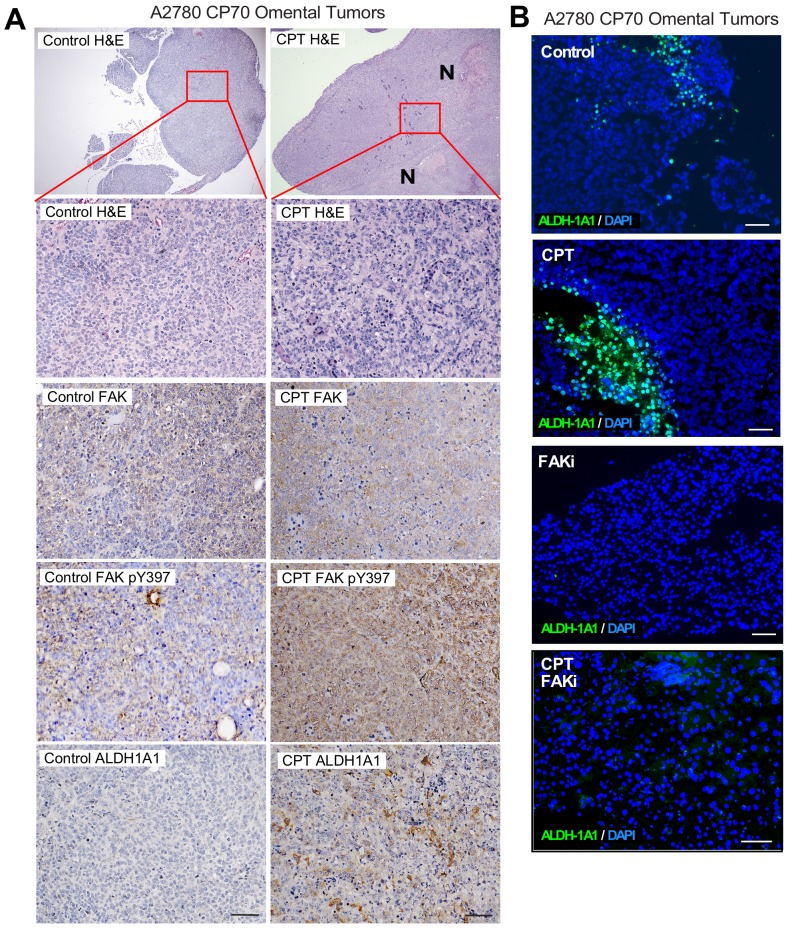
Elevated FAK Y397 phosphorylation and ALDH staining in non-necrotic regions of CPT-treated mice with A2780-CP70 tumors.(A) Representative immunohistochemical staining of paraffin-embedded omental tumor sections from control or CPT-treated A2780-CP70 tumors. Shown is 4X H and E (top) with a 20X magnification of region denoted with red box. Serial sections representing this H and E stained region were analyzed for total FAK, FAK pY397, and ALDH-1A1 staining (brown) with hematoxylin (blue) counter stain. N = Necrotic. Scale is 100 µm. (B) Representative immunofluorescent staining with antibodies to ALDH-1A1 (green) and DAPI (blue) from control, CPT, FAKi, or CPT plus FAKi treated mice with A2780-CP70 tumors. Scale is 100 µm.